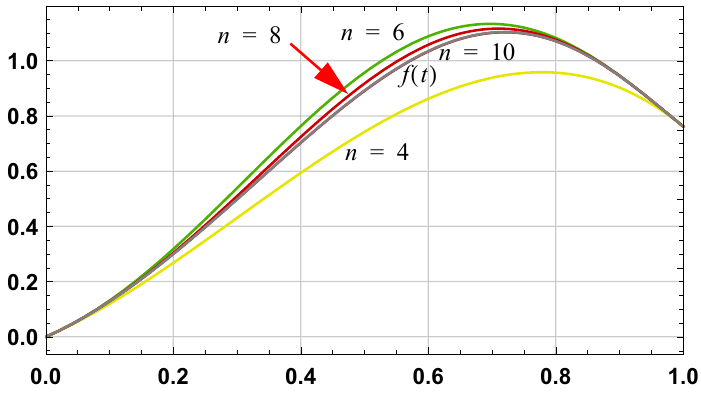
Figure 6. Graph of 4th, 6th, 8th and 10th order spline approximations, based on the interval [0, 1], Figure 6. Graph of , , and order spline approximations, for the function defined by based on the interval , for the function defined by (33).